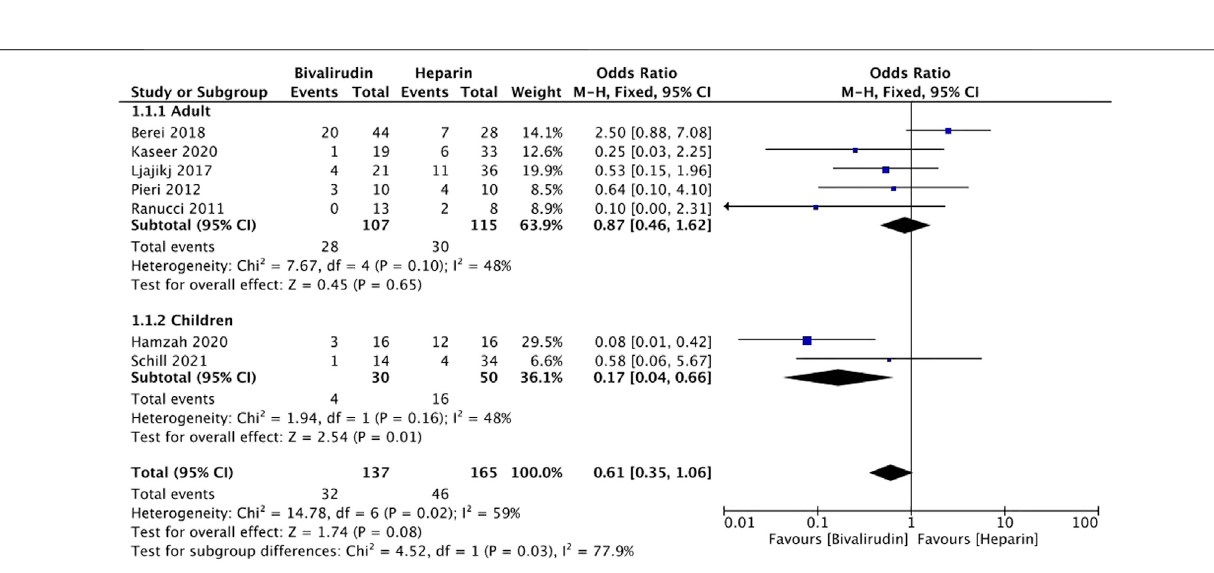
Frontiers in Pharmacology |